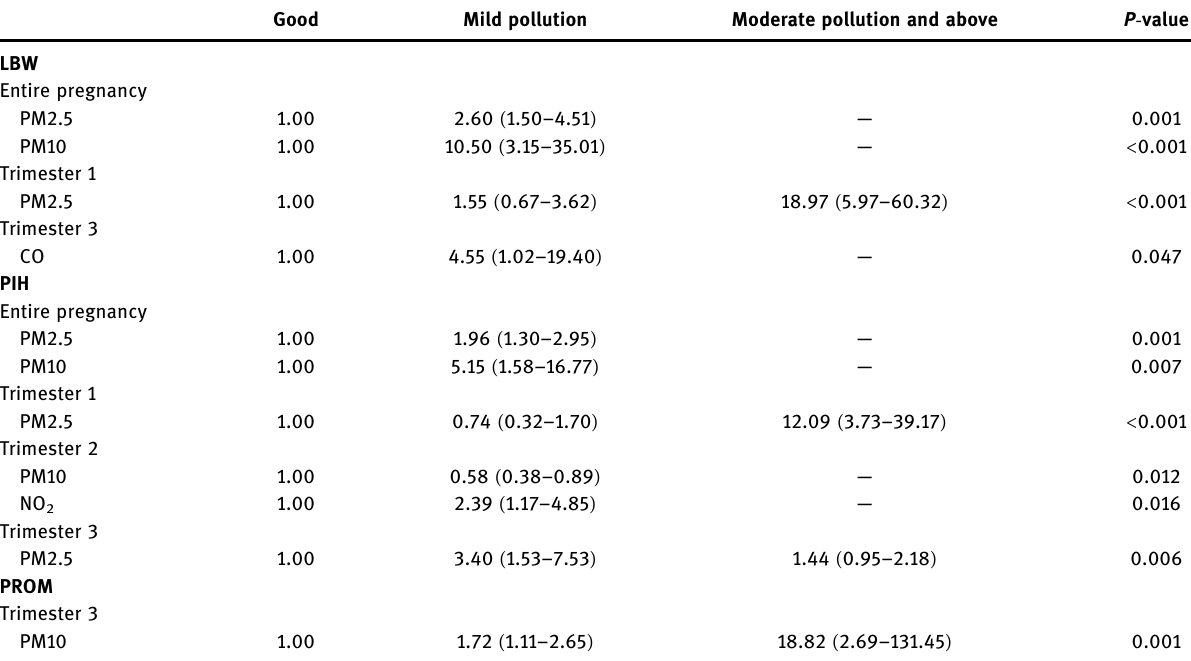
Good Mild pollution